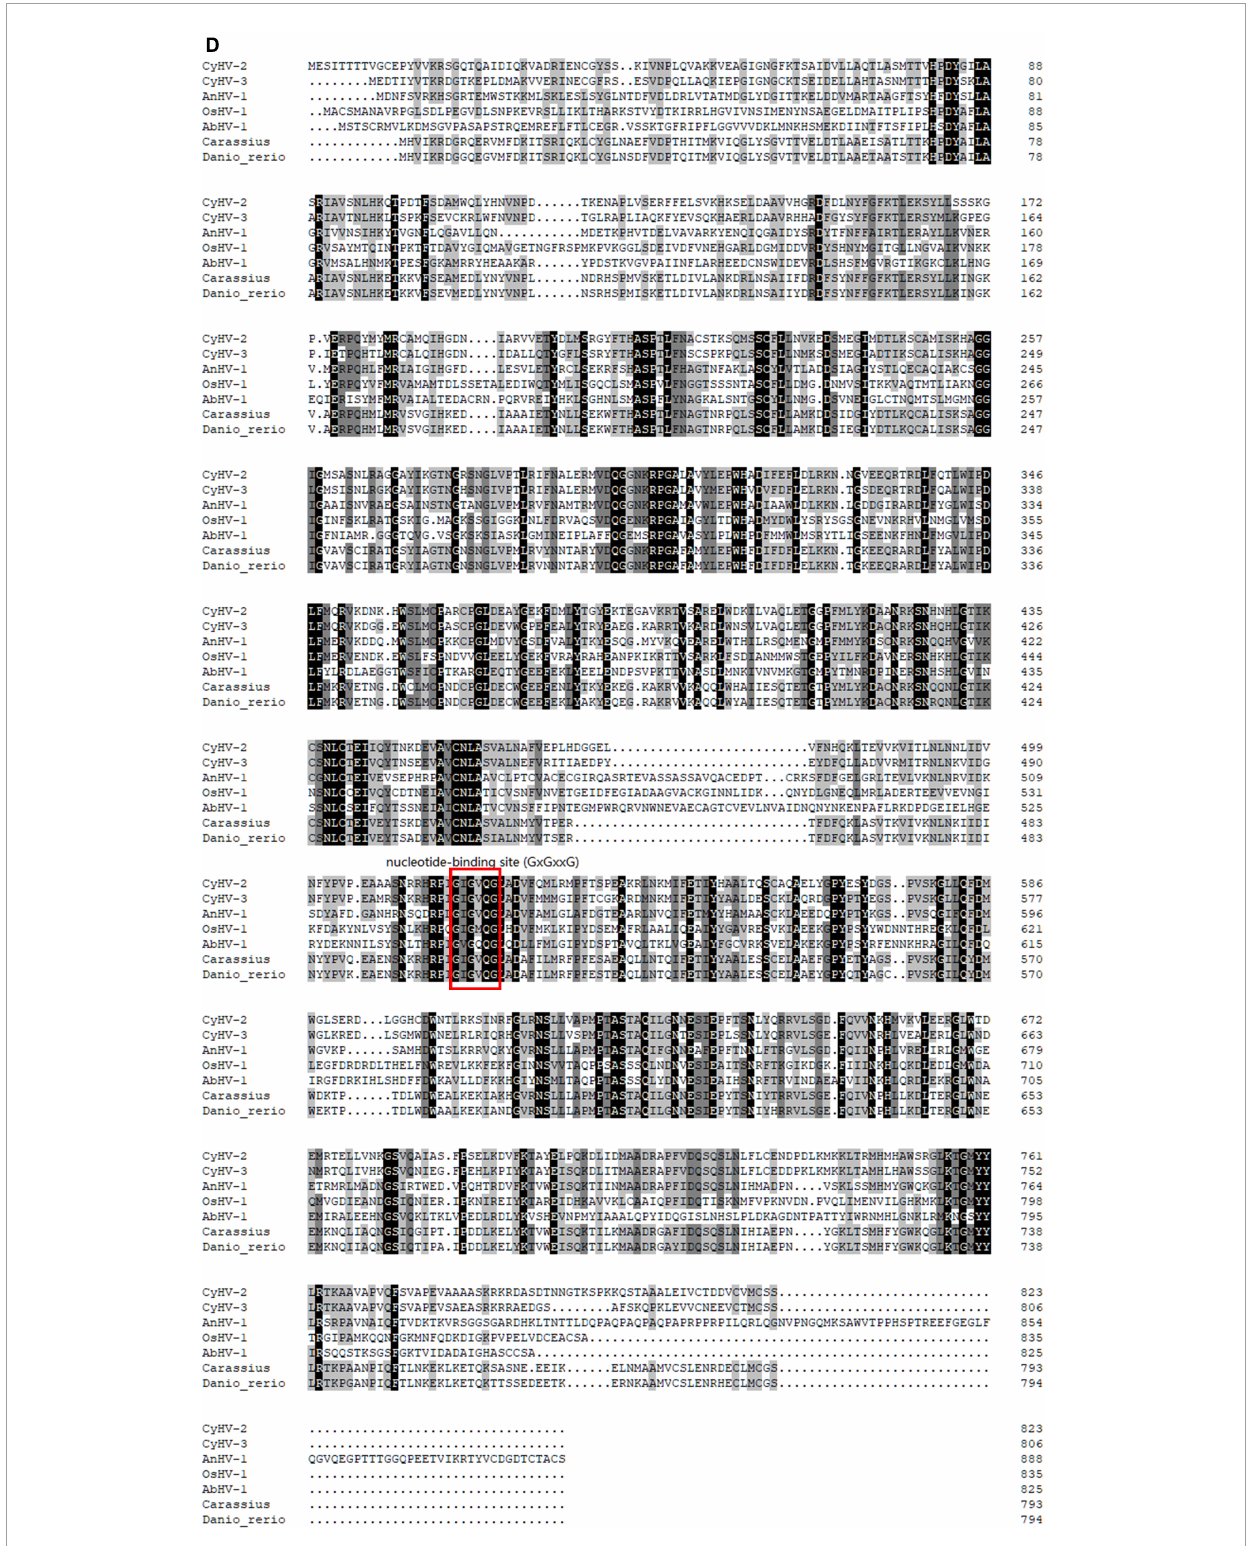
FIGURE1 Phylogenetic tree analysis and protein domain prediction of ORF23 and ORF141. Amino acid sequences were obtained from Uniprot website (https://www.Uniprot.org/). (A,B) The phylogenetic tree was constructed based on the amino acid sequences of CyHV-2 ORF23 and ORF141, by using the neighbor-joining method in MEGA11.0 software. The evolutionary tree differentiation node shows 1,000 bootstrap replications. Smart (http://SMART.embl-heidelberg.de/) software was used to analyze the protein structure, and different protein domain were labeled with regions in different colors. (C) Alignment of CyHV-2 ORF23 with full-length among other species and herpesviruses, by using DNAman 8.0 software. (D) Alignment of CyHV-2 ORF141 with full-length among other species and herpesviruses, nucleotide binding site was marked in red